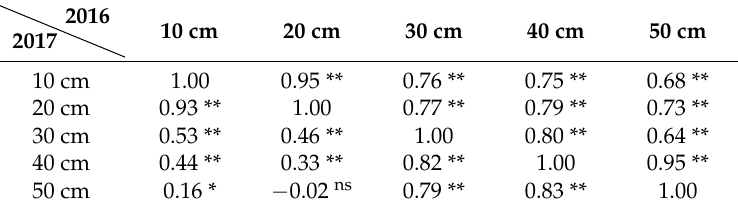
Table 4. Correlation between SWC of each soil layer in different precipitation years.